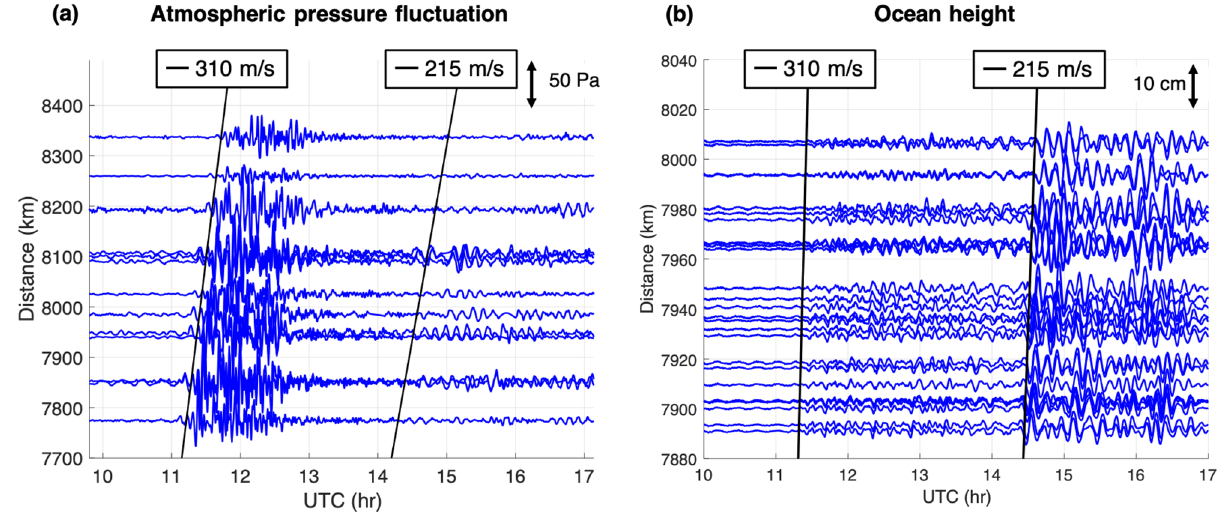
Figure 3. ( a ) Waveforms were obtained by the KUT infrasound network at 7700–8400 km from the Tonga volcano. A Lamb wave with a velocity of 310 m/s was observed 7 h after the eruption; the shapes of the waveforms were similar for every observation location in Japan. Several hours after the Lamb wave, long-lasting gravity waves with a velocity of 215 m/s were also observed across Japan. ( b ) The sea-level changes are calculated from DONET2 water pressure changes. DONET2 is installed near the KUT infrasound network. As in the KUT network, waves were observed with velocities of 310 m/s and 215 m/s, but the relationship with the magnitude is